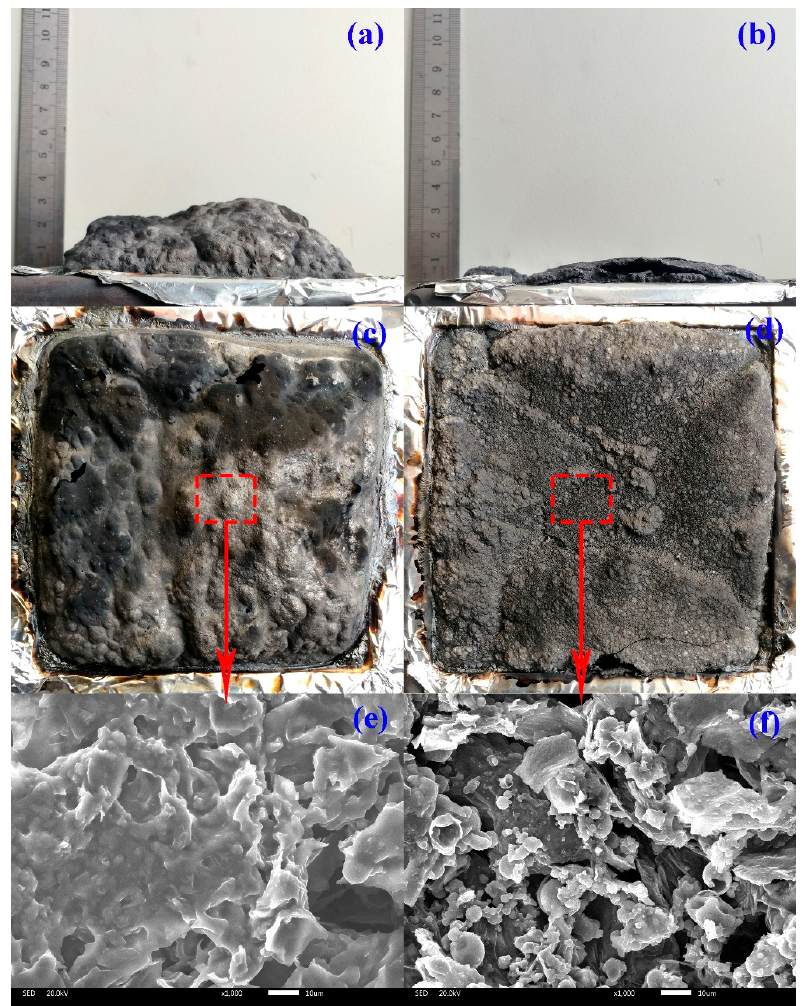
Figure 11. Digital photographs and SEM images of char residues for PE3 ( a , c , e ) and PE5 ( b , e , f ) after CCT.